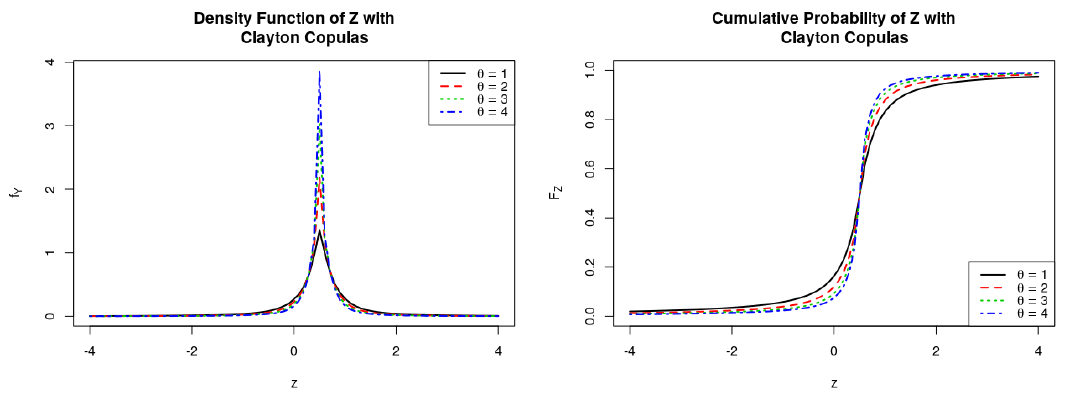
Figure 6. PDFs and CDFs of the ratio Z = X 1